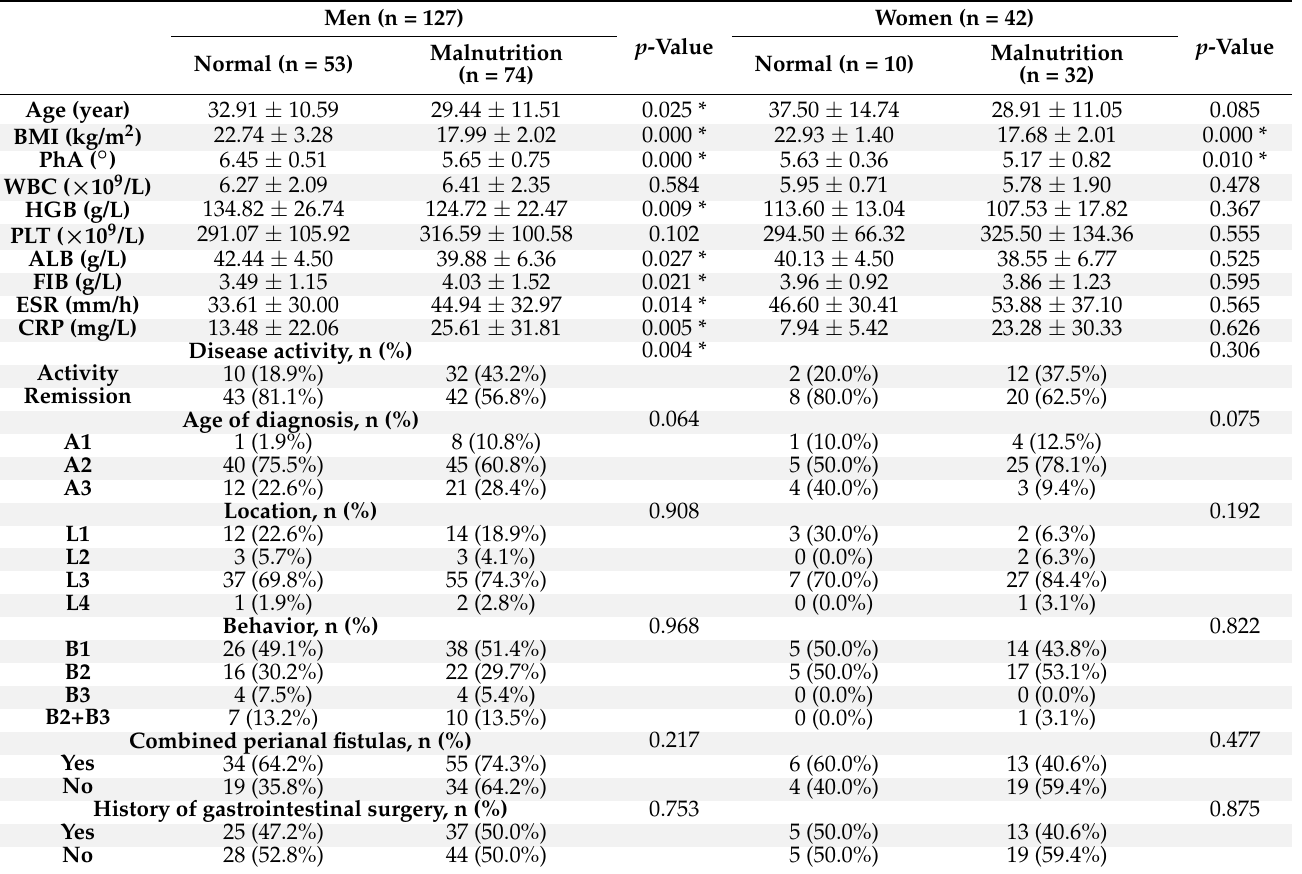
Table 2. Comparison of patient characteristics, body composition, and clinical data between adequate nutrition status and malnutrition in CD.